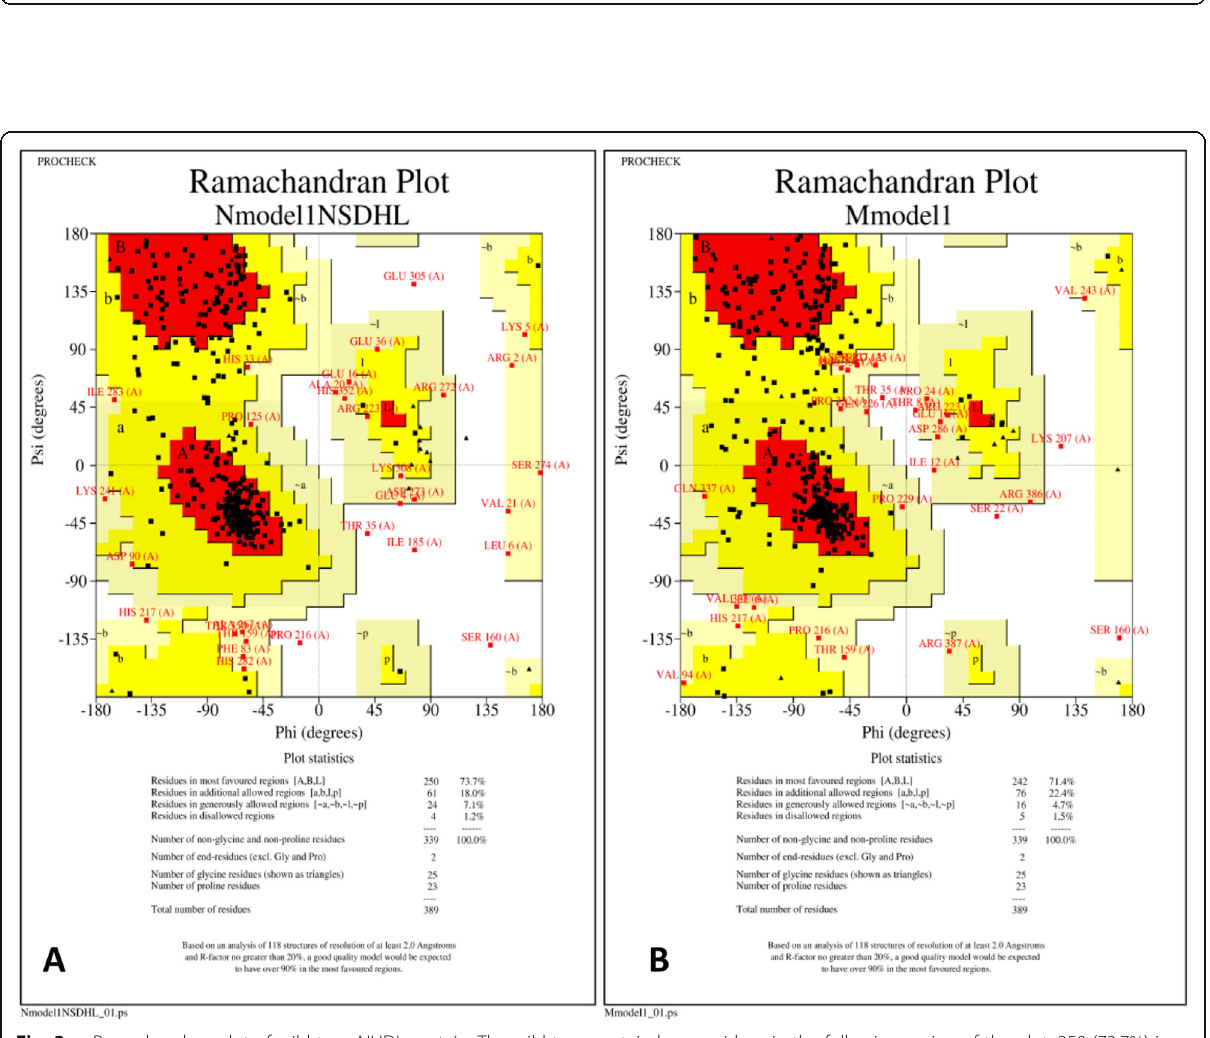
Fig. 2 a- Distribution and B factor values of alpha helices and beta sheets in wild type protein, b - In mutant protein both show similar distribution